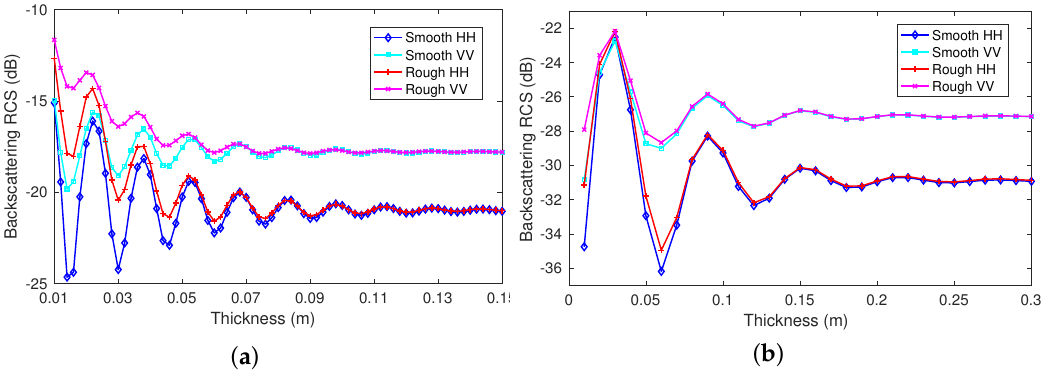
Figure 8. Backscattering RCS with respect to the thickness of the newly formed sea ice at an incidence angle of 40 ◦ for ( a ) C-band and ( b ) L-band. The HH and VV results were simulated for both smooth and rough ice–water interfaces.